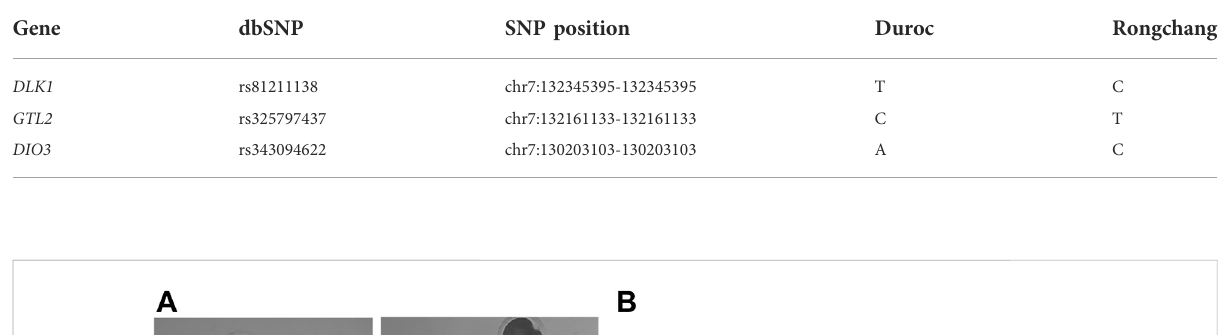
TABLE 1 DLK1 , GTL2 , and DIO3 gene SNPs in both Rongchang and Duroc minipigs.